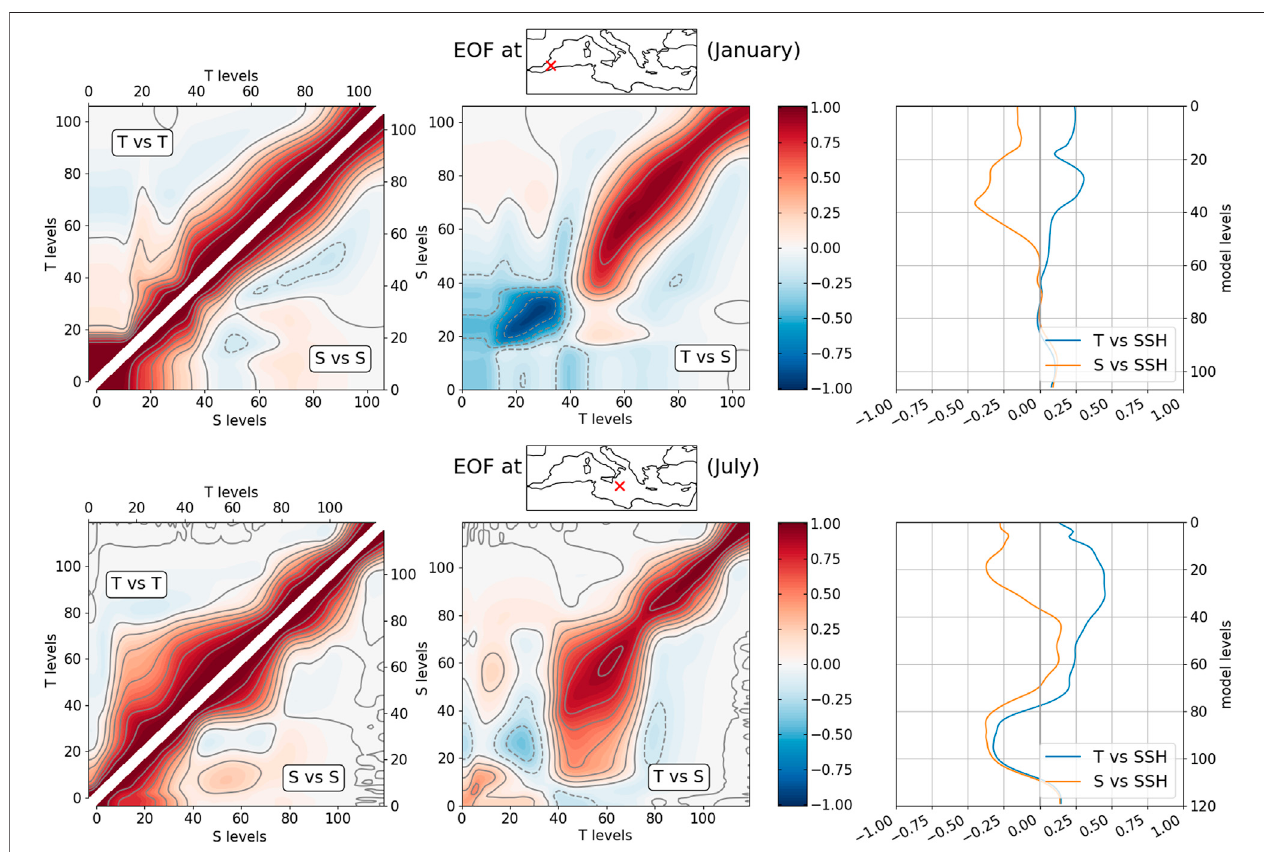
FIGURE 2 | Examples of correlations computed from the EOF on two model grid points for two different months: January on the upper row and July on the lower row. On each row, the left is the correlation obtained between temperatures (and salinities) at different model levels, the center is the correlation between temperature and salinity at different levels and the right is the correlation between SSH and temperature (or salinity).